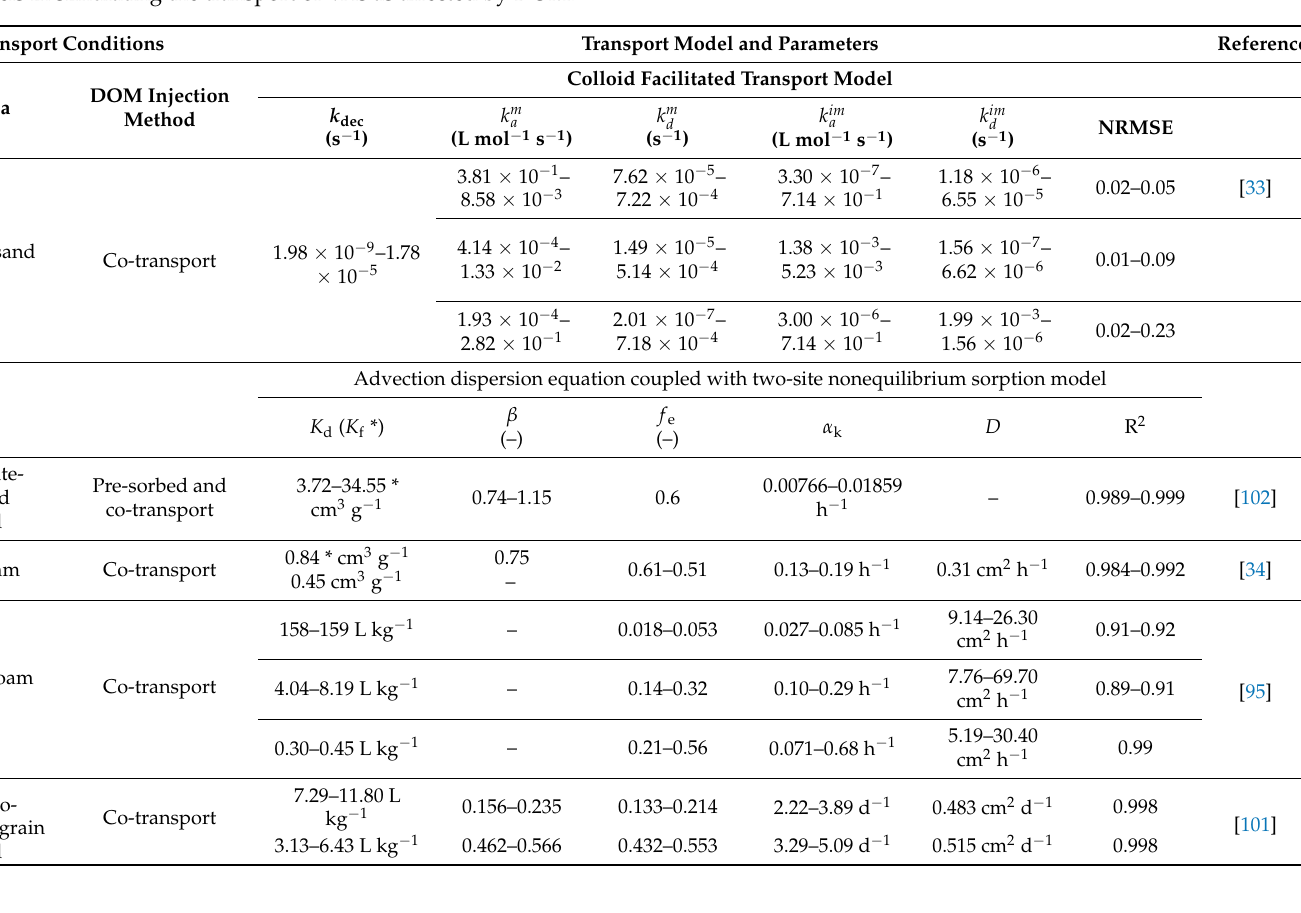
Table 3. Applications of models in simulating the transport of VAs as affected by